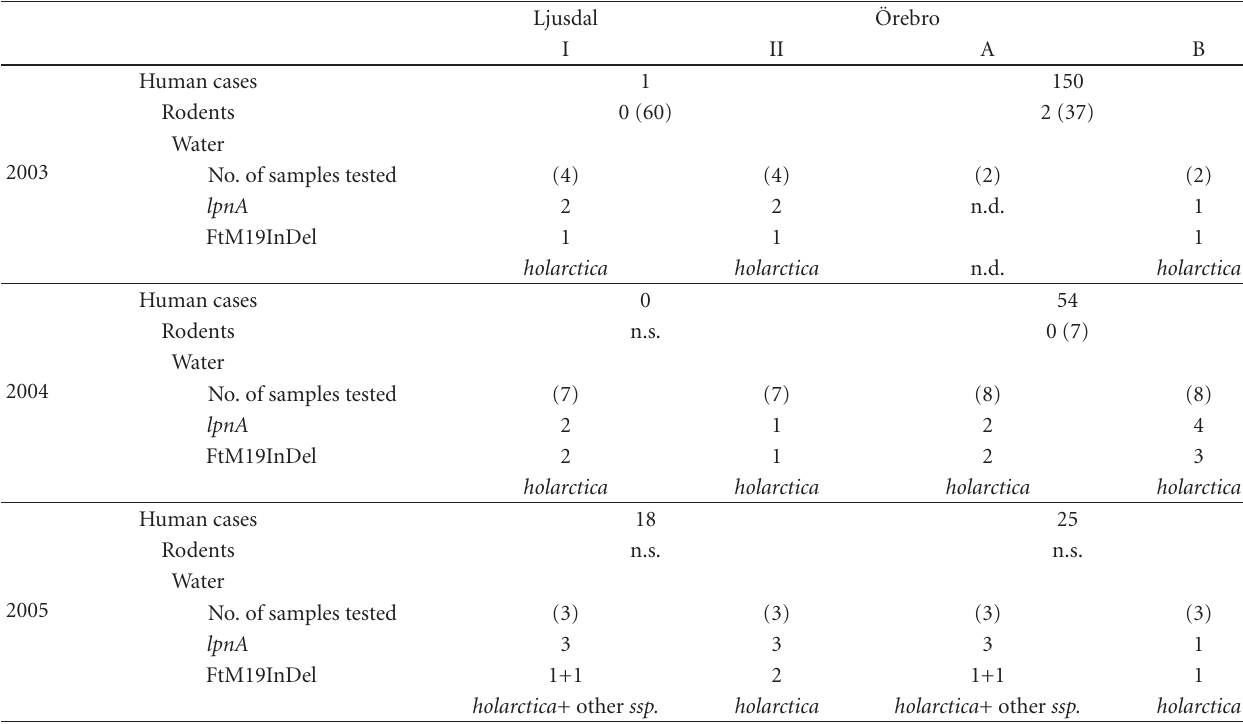
Table 1: Reported human tularemia cases (County Medical O ffi cer, G¨avle-Sandviken, personal communication, and Swedish Institute for Infectious Disease Control, SMI, ¨Orebro County) and F. tularensis subsp. holarctica culture-positive rodents in the Ljusdal and ¨Orebro areas during the study period. The total numbers of trapped rodents are shown in parentheses. Results of the molecular analysis of water samples from the four sampling points selected for detailed examination. Positive lpnA assay results indicate the presence of F. tularensis. The length of resulting FtM19InDel sequences indicates the presence of F. tularensis subsp. holarctica or other F. tularensis subspecies (other ssp.). n.d., not detected; n.s., not sampled.